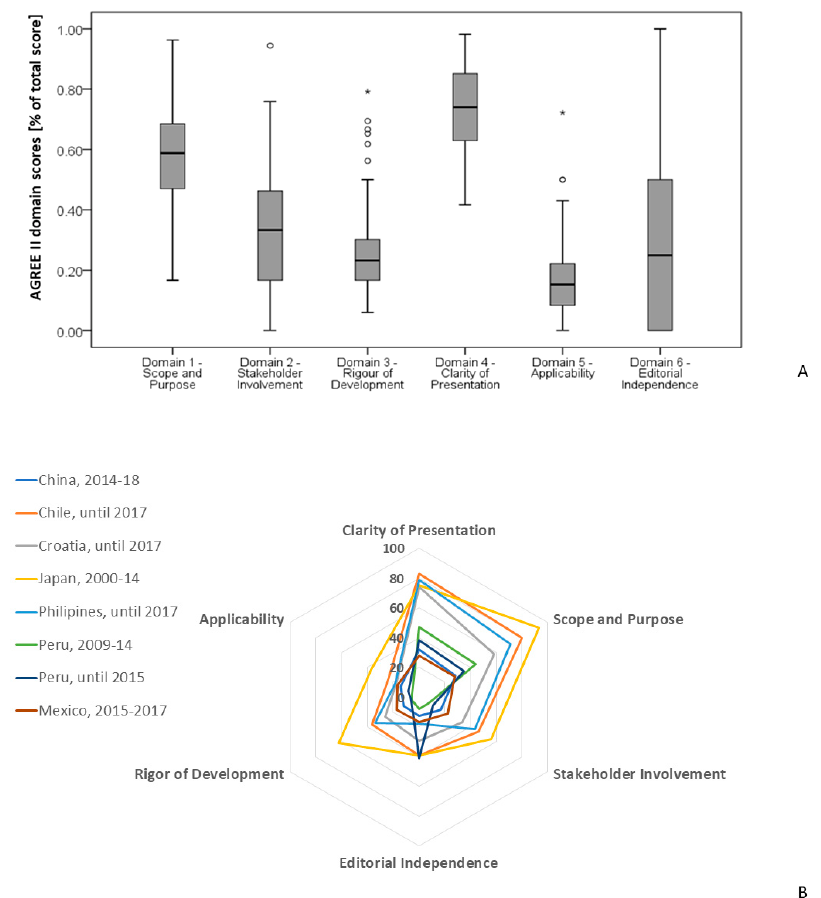
Figure 2. Standardized domain score distribution across six AGREE II domains: ( A ) among the Croatian clinical practice guidelines, N = 74. Outliers and extreme outliers are represented by circles and asterixis, respectively; ( B ) among countries that used AGREE II to evaluate national guidelines.